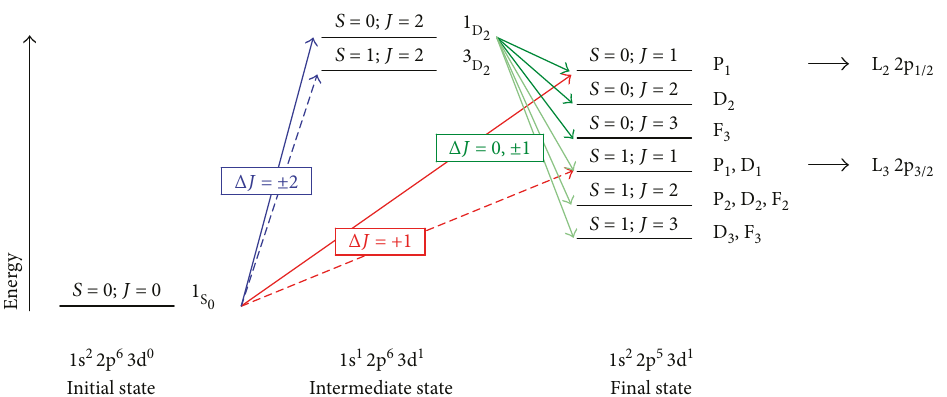
Figure 11: Atomic term scheme with spin-orbit coupling for Ti 4+ (3d 0 ) comparing the two-step (1s XAS, 2p XES) 1s2p RIXS and the one-step 2p XAS pathways. The two 1s XAS transitions are separated by the small 3d SOC, Coulomb, and exchange interactions; hence, the splitting is small. The direct dipole transitions in 2p XAS can only populate the fi nal states with J = 1 , while the dipole decays in 2p XES can reach fi nal states with J = 1, 2, and 3 . However, terms with J = 0 or 4 cannot be populated in either case and thus do not contribute to the spectrum. Nonaccessible terms are omitted for